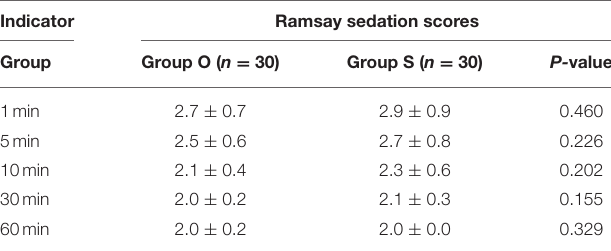
TABLE 5 | Comparison of Ramsay sedation scores between the two groups after extubation. Indicator Ramsay sedation scores Group Group O ( n = 30) Group S ( n =